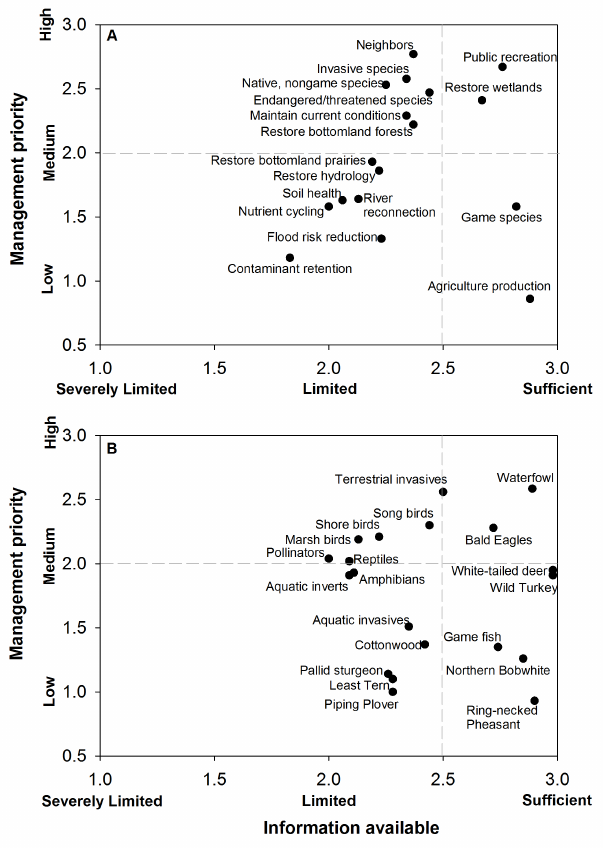
Fig. 3 . Average survey responses (N = 54) across the study area for management priority and level of scientific information available to manage for selected (A) objectives and (B) conservation targets on floodplain conservation lands. Dashed lines are breakpoints to differentiate between high and low priorities and sufficient and limited amounts of information